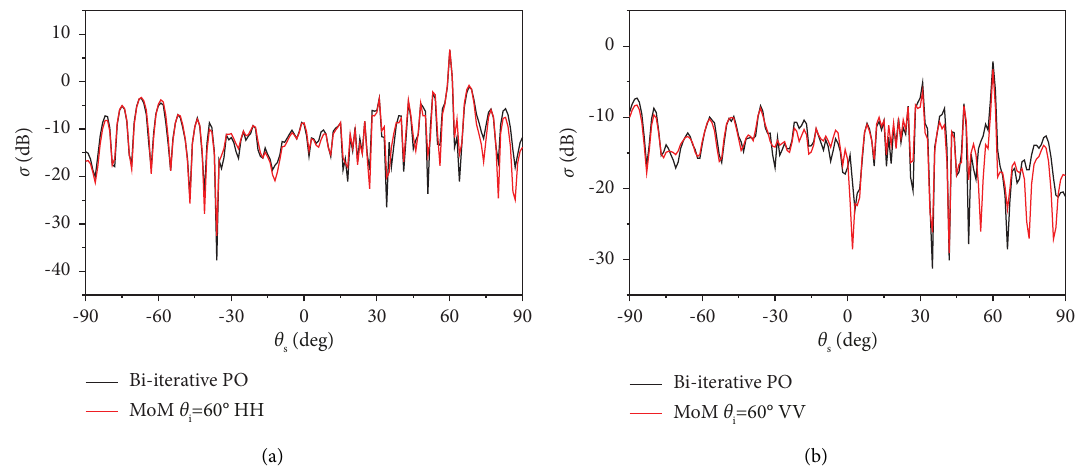
Figure 3: Comparison of NRCS from a cylinder above two-layered soil surfaces using the bi-iterative PO and MOM with (a) HH and (b) VV polarizations.